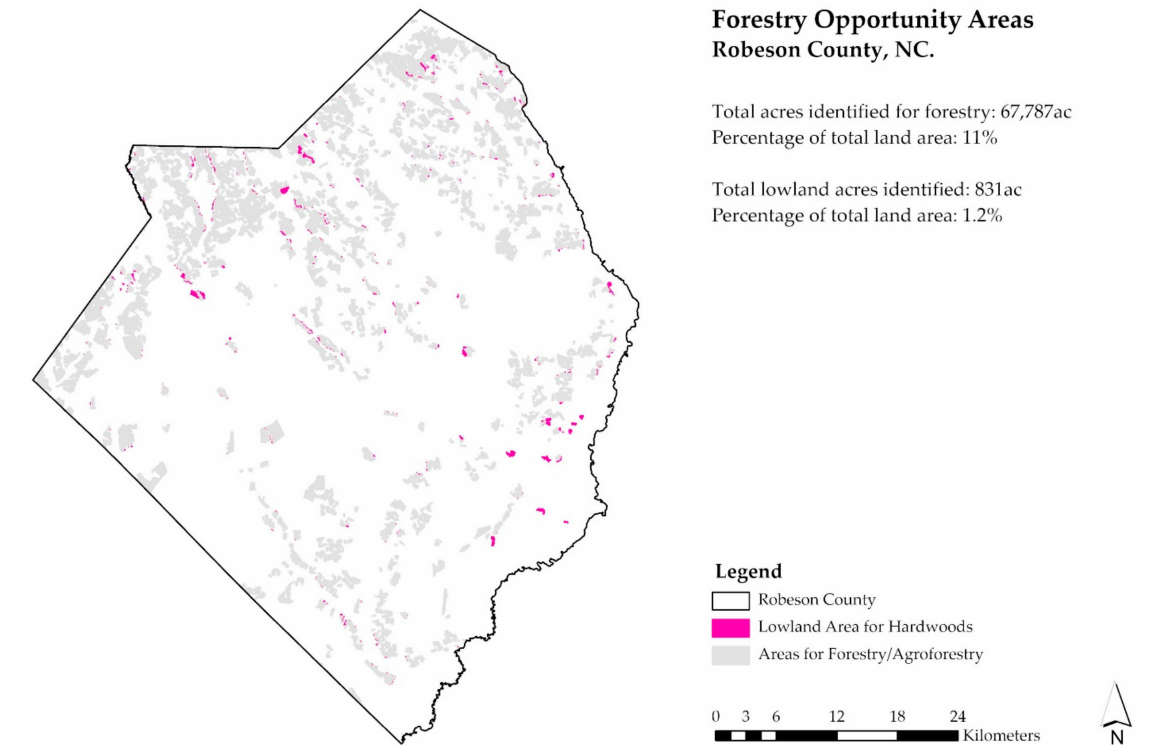
Figure 12. Forest and tree planting opportunity areas in Robeson County.